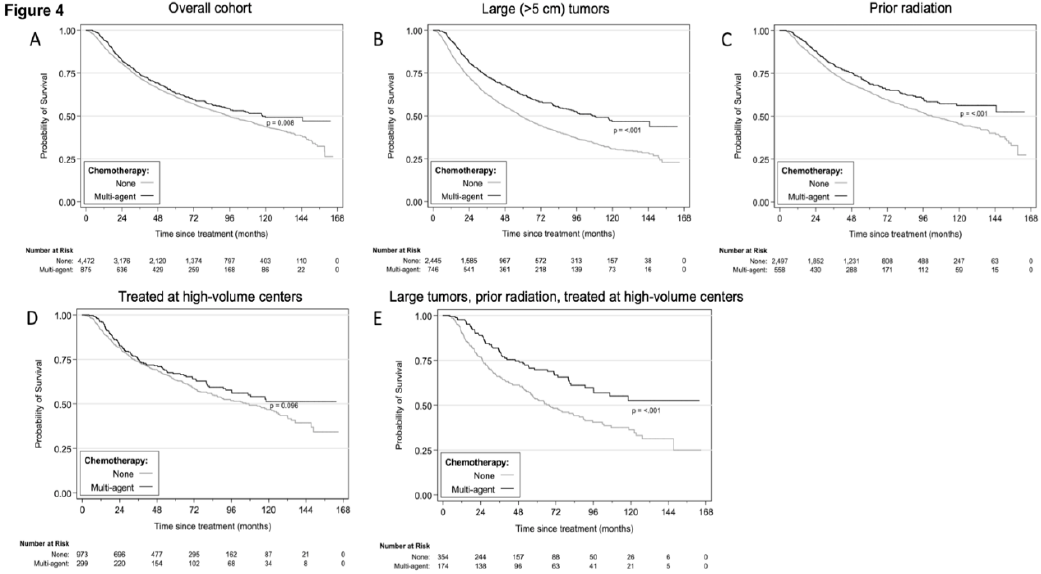
Figure 4. Kaplan–Meier analysis demonstrating the association between multi-agent chemotherapy use and OS in the overall cohort ( A ), in patients with large ( > 5 cm) tumors ( B ), with prior radiation ( C ), treated at high-volume centers ( D ), and in patients with primary high-grade extremity and trunk STS who had large ( > 5 cm) tumors and were treated with radiation at high-volume centers ( E ). Study sample derived from the NCDB from 2004 to 2016. NCDB = National Cancer Database; OS = overall survival; STS = soft tissue